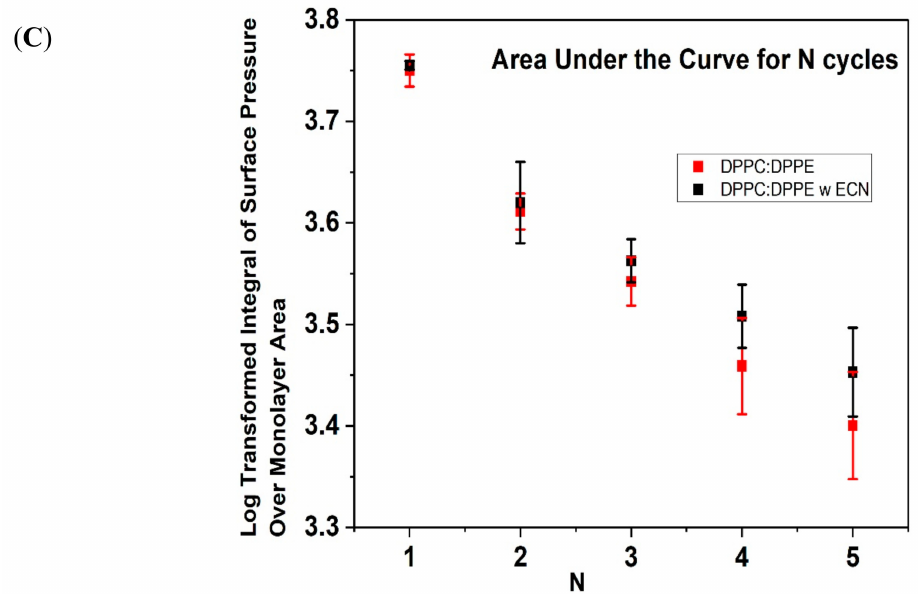
Figure 4. ( A ) Surface Pressure versus area of the trough isotherms for DPPC:DPPE (7:3) without (control, red solid line) and with 1 wt% ECN (black solid line). All samples were compressed and expanded five times. The data has been represented as the mean of 3 samples. ( B ) The initial part of the 4th and 5th compression cycles of DPPC:DPPE monolayers with (black lines) and without (red lines) the ECN, showing the lift o ff area for each compression cycle. ( C ) Area under the curve as a function of compression / expansion cycle for DPPC:DPPE (7:3) without (control, red square) and with 1 wt.% ECN (black square). The log-transformed mean and standard deviation of three samples have been shown in the